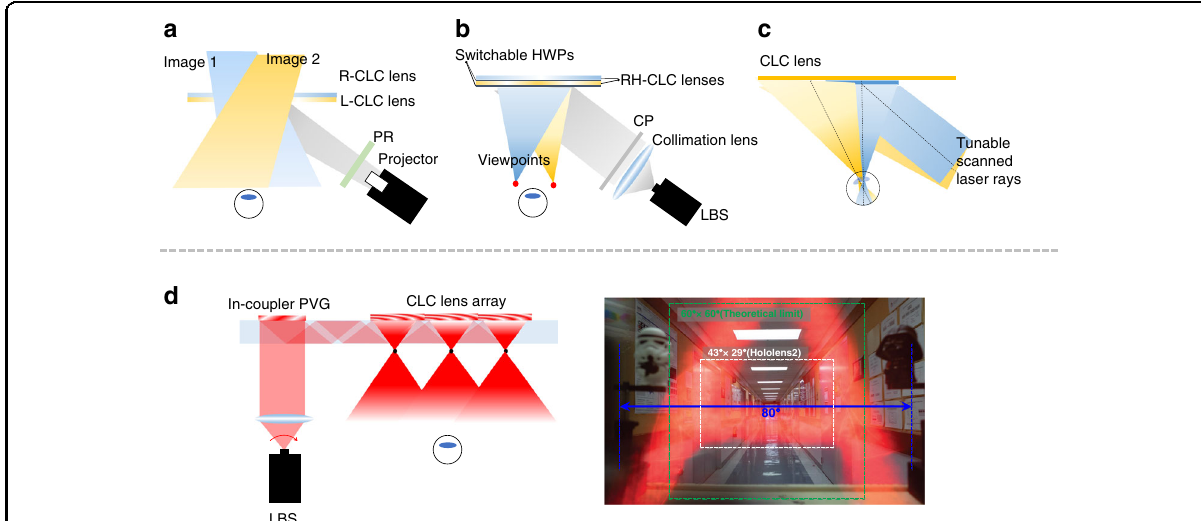
Fig. 16 Schemes for off-axis CLC lens and applications in AR system. a Doubled FoV AR display; b Pupil steering Maxwellian AR display; c Gaze- matched pupil steering Maxwellian display. d Scanning waveguide AR display. LBS: laser beam scanning. Reproduced from d ref. 229 with permission from The Optical